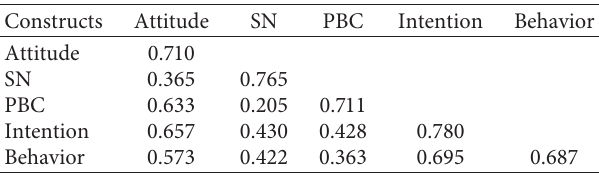
Table 4: Correlations between